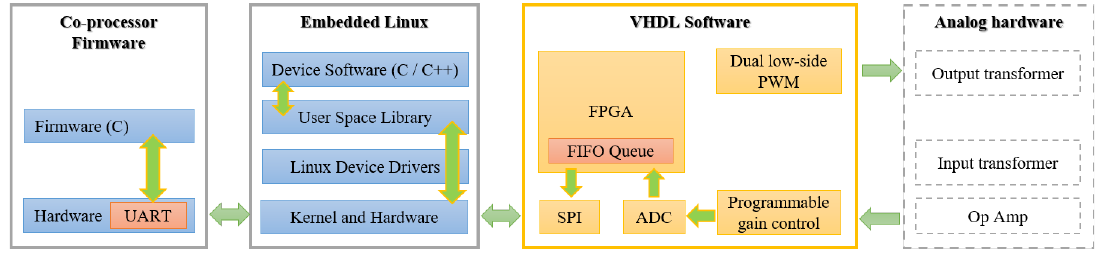
Figure 8. The block diagram of software components used in